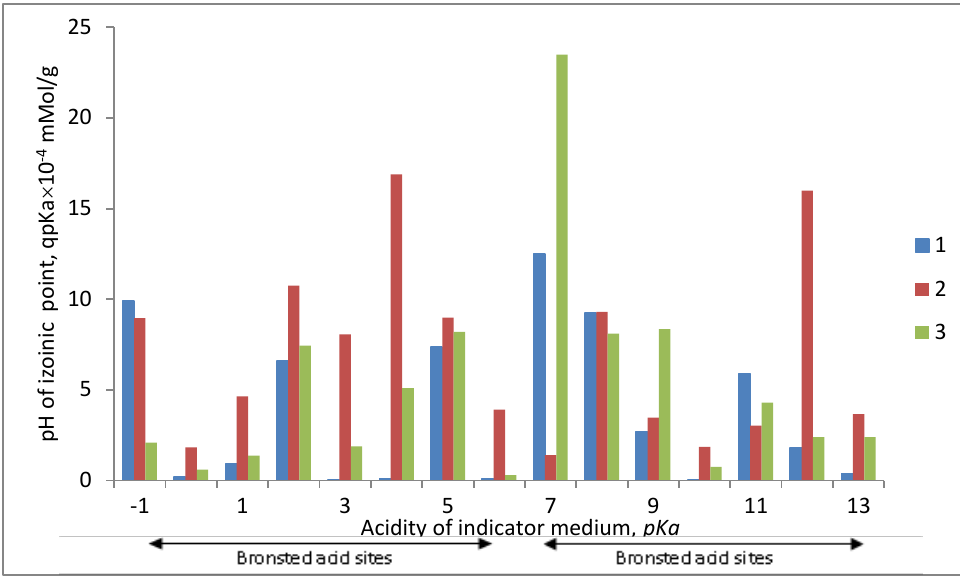
Figure 4. Spectra of adsorption centers’ distribution on the PP fiber surface: ( 1 )—raw; ( 2 )—modified by Fe 0 using the SHF method; ( 3 )—modified by Fe 0 using the II method.